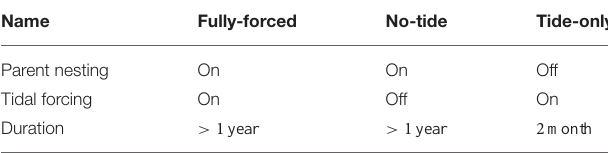
TABLE 1 | Description of the different numerical simulations.